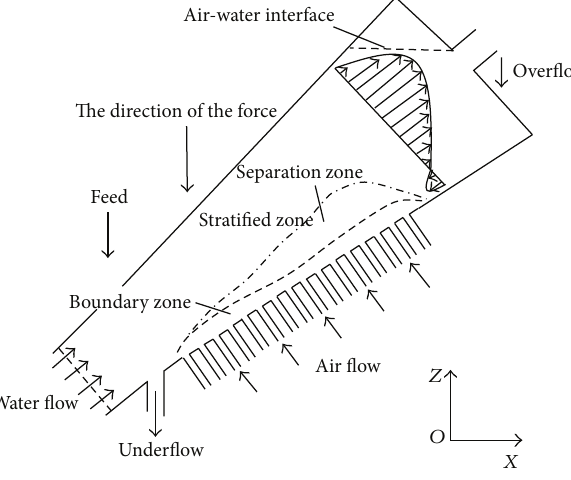
Figure 3: Flow field distribution in